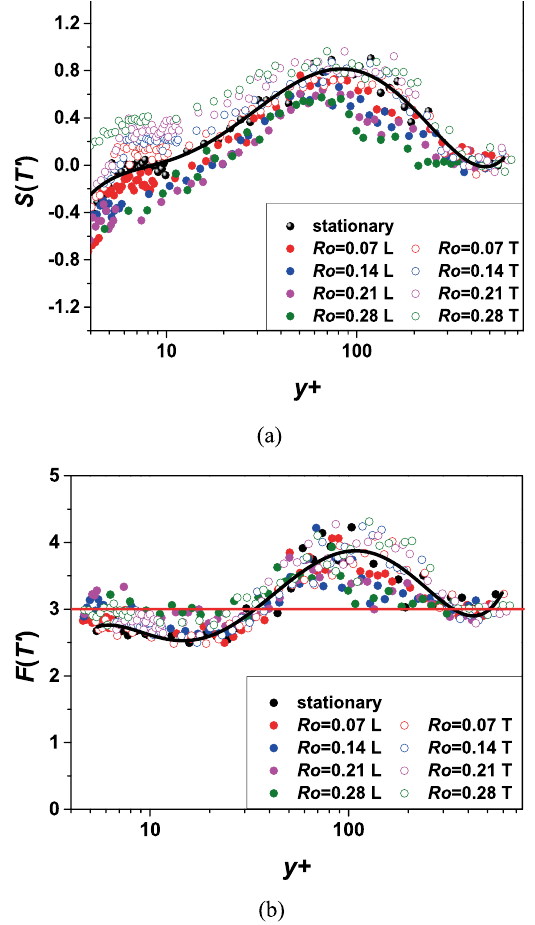
Figure 10. Profiles of the skewness and flatness at location